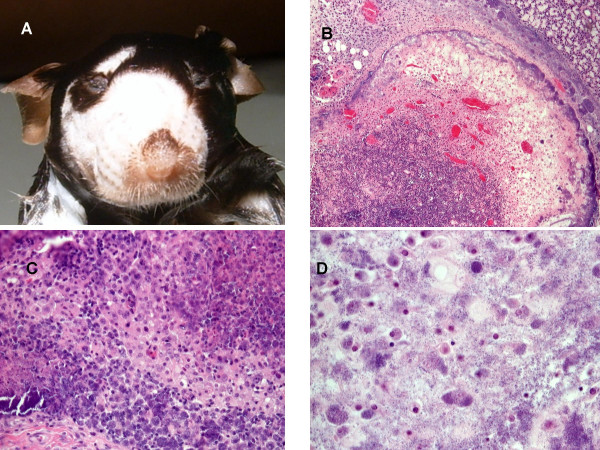
Gross examination showed marked facial and submandibular swelling (A). Histopathology of cervical (B) and mesenteric (C, D) lymph nodes showing acute, severe, necrotizing lymphdenitis and cellulitis with intralesional bacteria at 4× (B), 10× (C) and 20× (D) magnification. Acute severe necrosis (C) of mesenteric lymph node.